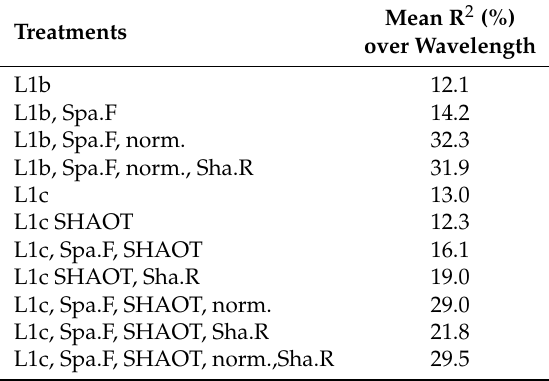
Table 3. Mean proportion of variance explained by the tree species identity (mean R 2 over the entire spectrum) for each processing level (data acquired on the 19 September). The treatments are listed in order of application. Mean R 2 Treatments